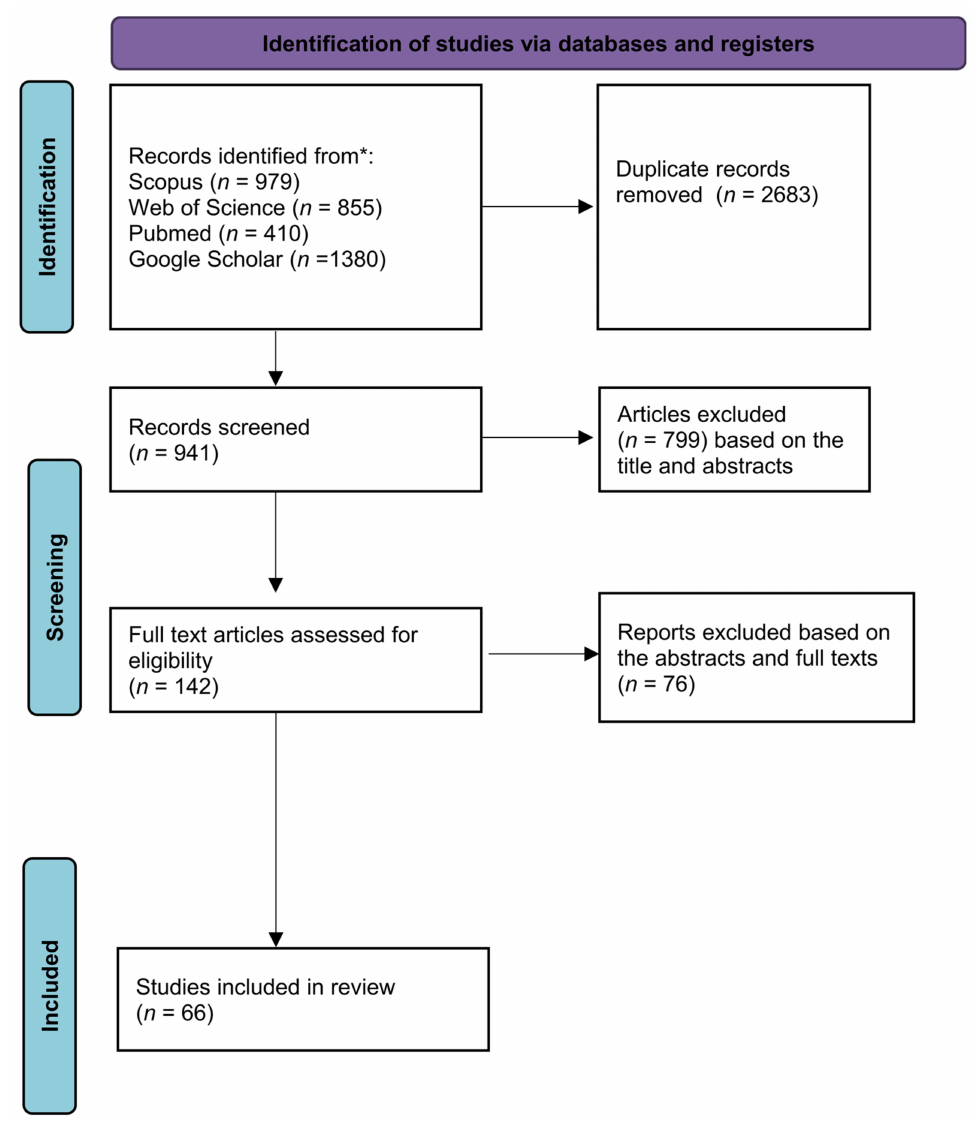
Figure 1. The screening process of the studies adapted from Preferred Reporting Items for Systematic reviews and Meta-Analyses